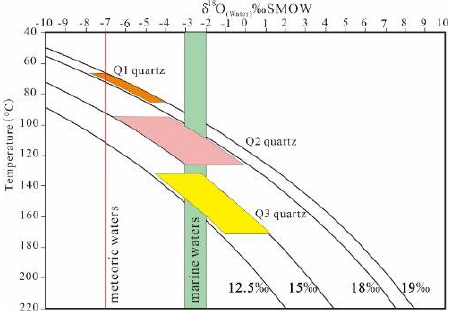
Figure 8. Plot of δ 18 O (water) in equilibrium with δ 18 O (cement) = 12.5, 15, 18, and 19‰ as a function of the temperature [29], Late Triassic marine waters, δ 18 O (water) = approximately − 3 to − 2‰ [33,34], and meteoric waters, δ 18 O (water) = − 7‰ [4,35].